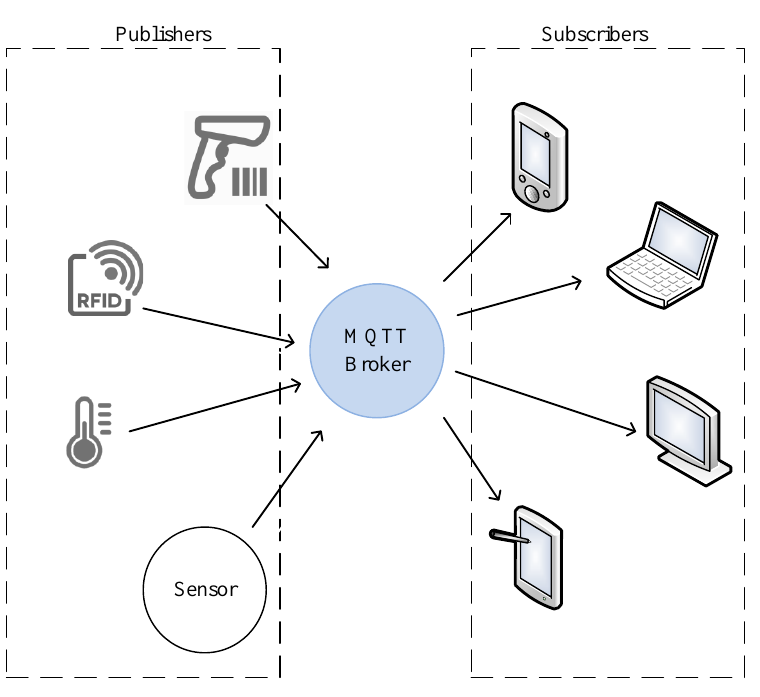
Figure 9. MQTT architecture for the Internet of